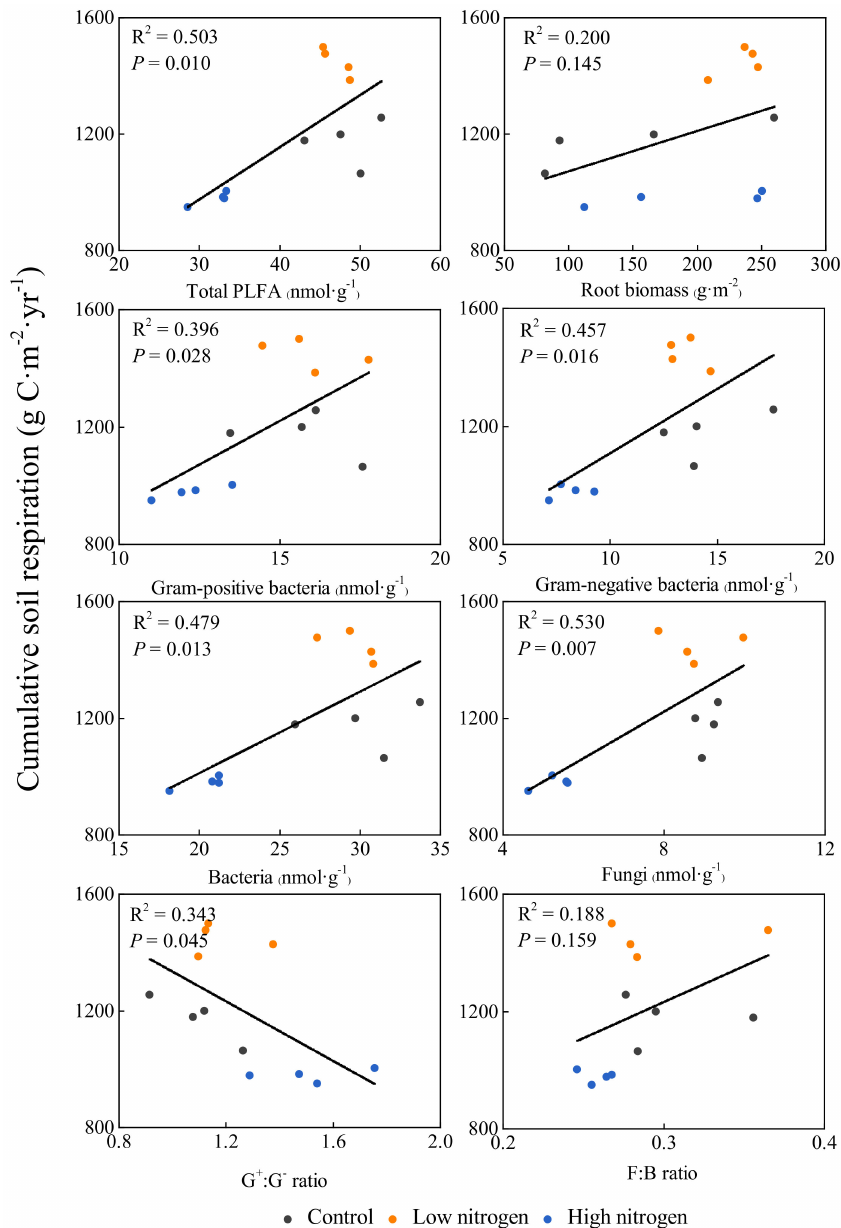
Figure 5. Linear relationships between annual cumulative respiration in 2015 and concentrations of PLFA, microbial community structure ratios, and root